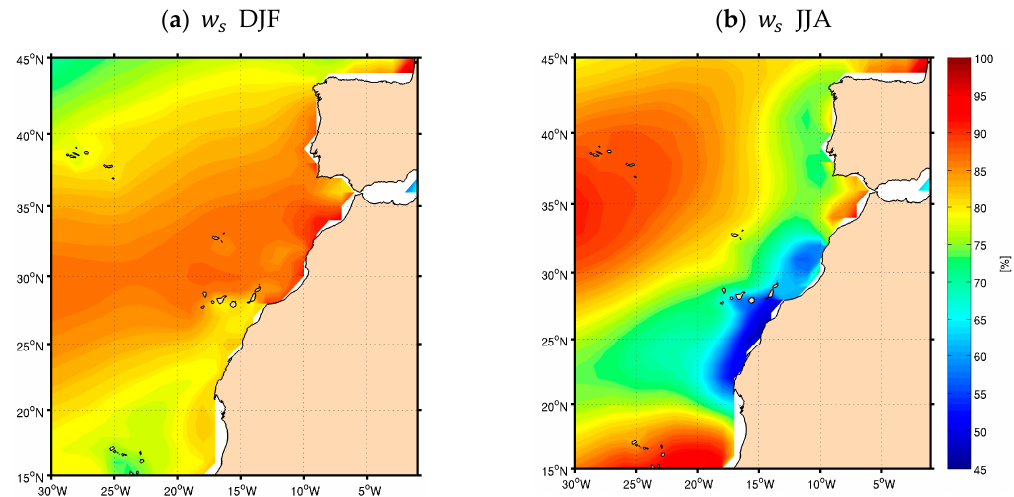
Figure 9. Climatological distribution of the swell spectral weight ( w s ; dimensionless) for ( a ) DJF and ( b ) JJA.